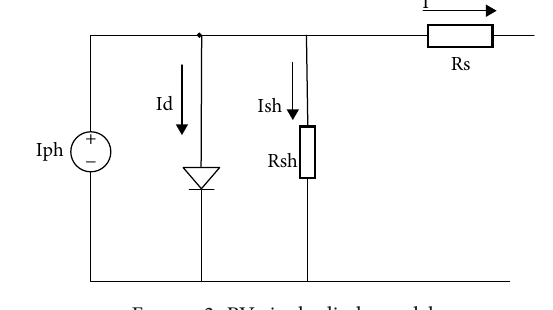
Figure 2: PV single-diode model. Table 1: PV panel description.